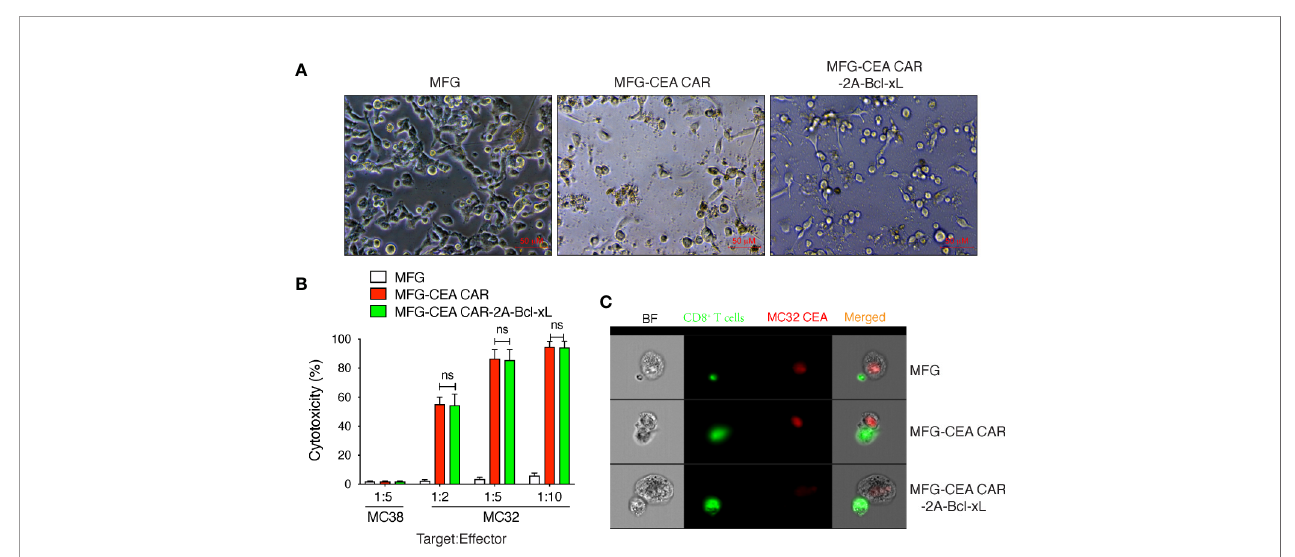
FIGURE 4 | Carcinoembryonic antigen (CEA) chimeric antigen receptor T (CAR-T) cells overexpressing Bcl-xL had modest in vitro cytotoxicity. GFP + CD8 + T cells were sorted ( Figure 2 ), and co-cultured with MC-38 or MC-32 tumor cells in vitro . The in vitro cytotoxicity was measured by the Cayman ’ s 7-AAD/CFSE Cell-Mediated Cytotoxicity Assay Kit. (A) Representatives of the in vitro co-culture of T cells with MC-32 tumor cells at 12 h (scale bars: 50 m m). (B) In vitro cytotoxicity assay. Data are representative with mean ± S.E.M. from three independent experiments (ns, not signi fi cant, P >0.05, Student ’ s unpaired t -test). (C) Representatives of the in vitro colocalization of CAR-T cells and tumor cells by Amnis image stream analysis. Data are representative of three independent